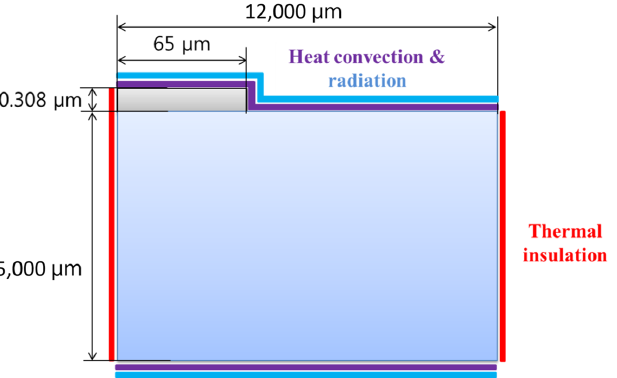
Figure 2. Schematic diagram of the two-dimensional model for the temperature estimation during the SCIS process.